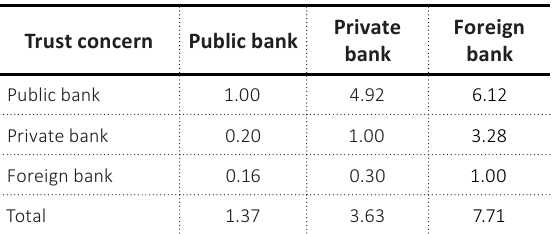
Table 2. Random inconsistency indices for n = 10